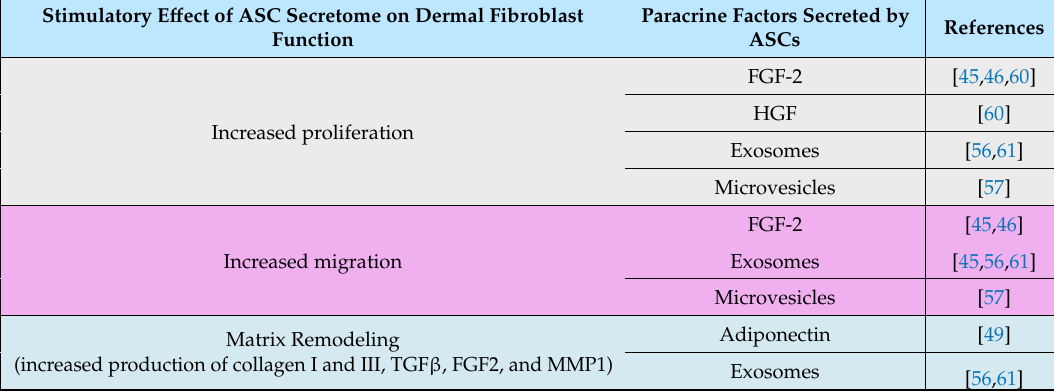
Table 1. The modulation of dermal fibroblast function by the ASC secretome: implications for improved wound